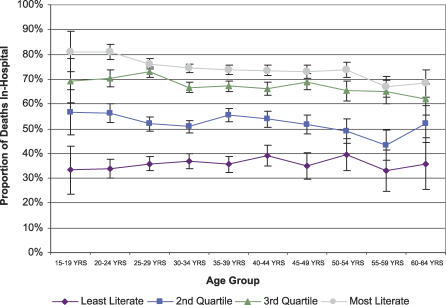
Proportion of HIV/AIDS Deaths That Were in Hospitals, versus Age Group, According to Community Literacy Quartiles, Mexico 1998–2005Data are means and 95% confidence intervals.